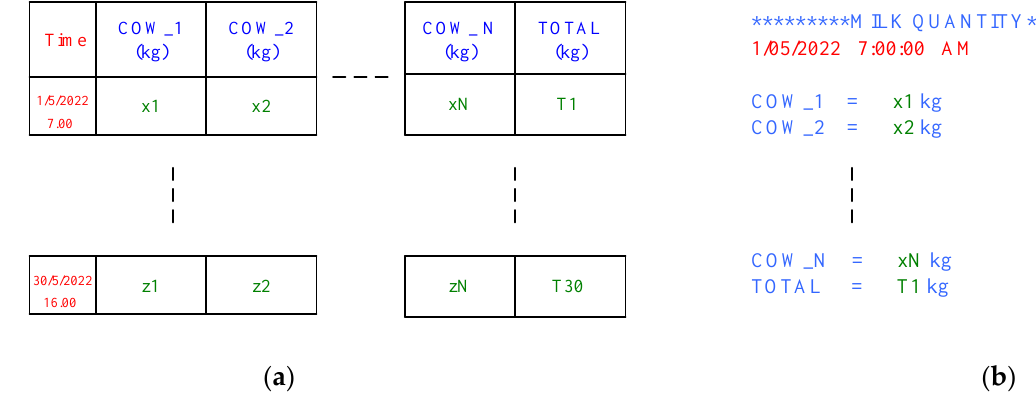
Figure 8. Data format: ( a ) Google sheet and ( b ) SD memory card.